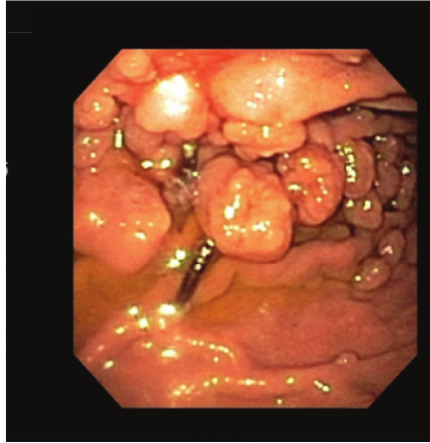
Figure 1: Upper endoscopy image taken prior to magnetic sphincter augmentation that shows multiple large polyps. Biopsy showed fundic gland polyps.